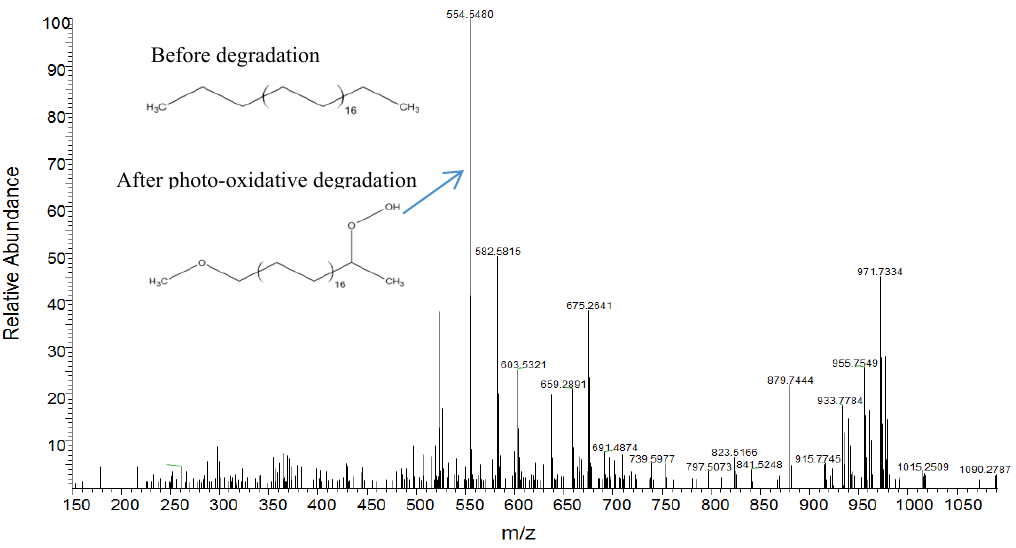
Figure 3. LESA-MS spectrum of an oxidized low-quality low-density polyethylene (LDPE). (Reprinted from [36] with permission of Elsevier).